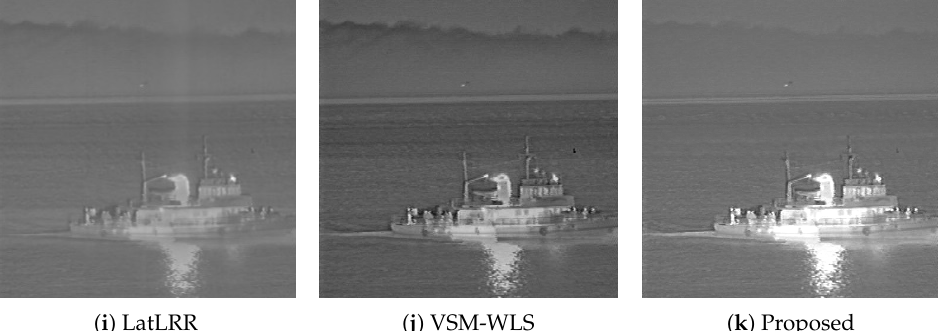
Figure 10. Image fusion results of the third group.